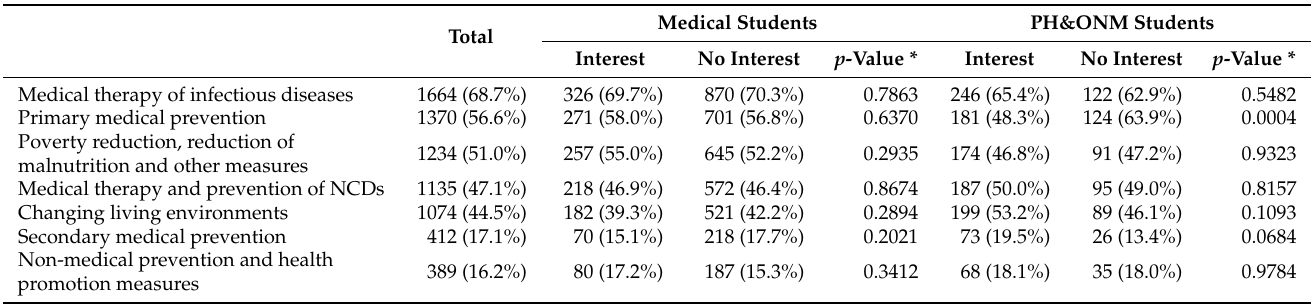
Table A4. Measures with assumed highest impact regarding the increase in life expectancy within the last 120 years: Absolute and relative proportion of the top three ranked measures by field of study and PHS interest in wave 1, OeGD-Studisurvey.